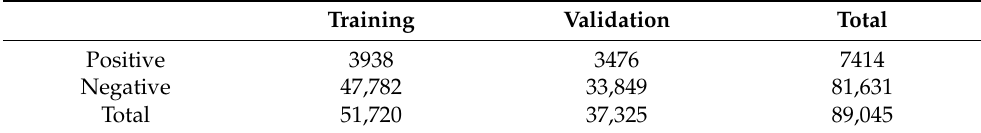
Figure 5. Distribution of training and validation sample tiles in the segmentation dataset. Table 2. Number of total, positive, and negative tiles in the study area used for training and validation.